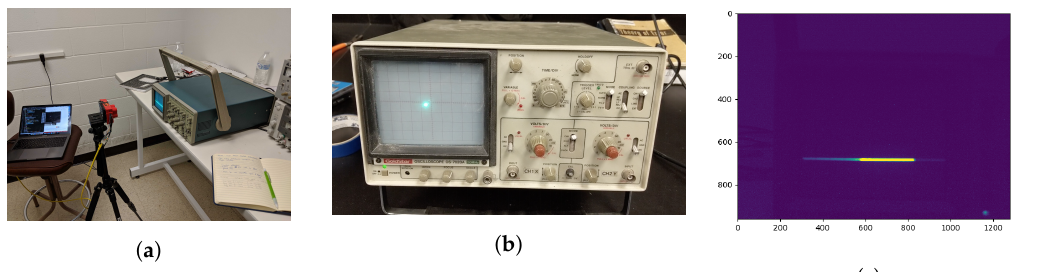
Figure 7. Exposure time error ( a ) setup, ( b ) example oscilloscope dot and ( c ) example RedEdge image. Images were used for analysis if the full line was imaged in the center of the frame. This ensures the proper exposure time could be measured.